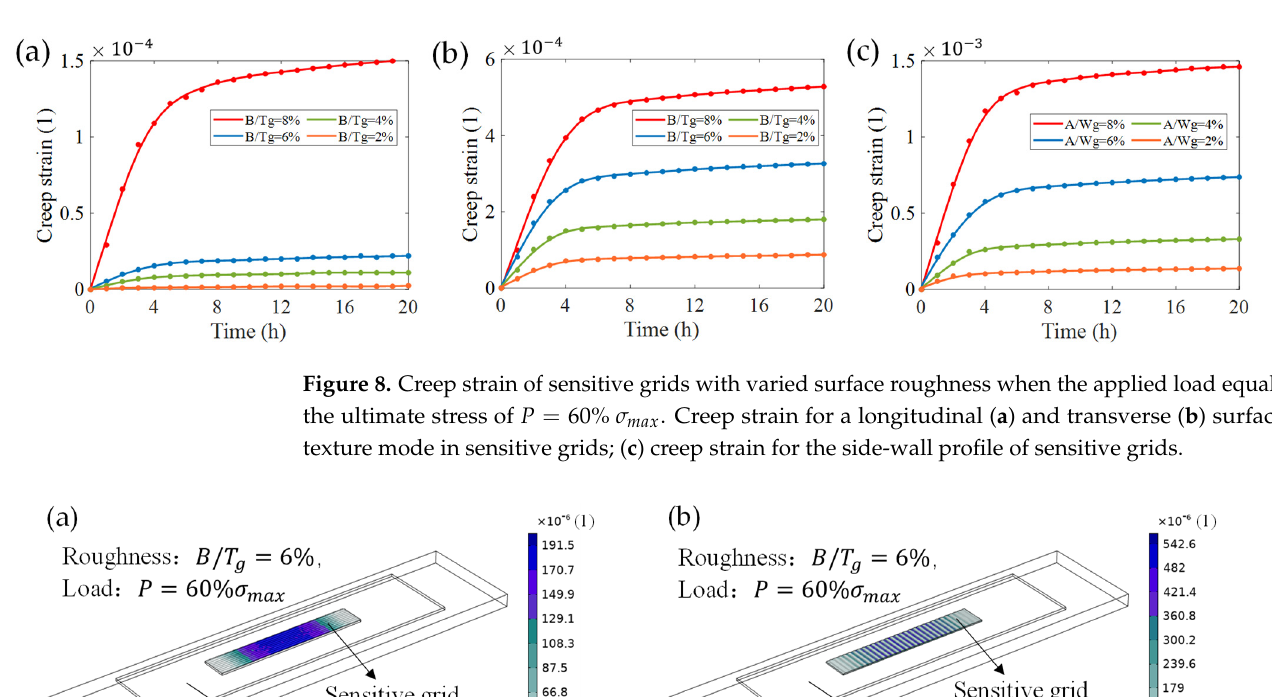
Figure 9. Creep strain distribution for a longitudinal ( a ) and transverse ( b ) profile mode of sensitive grids.